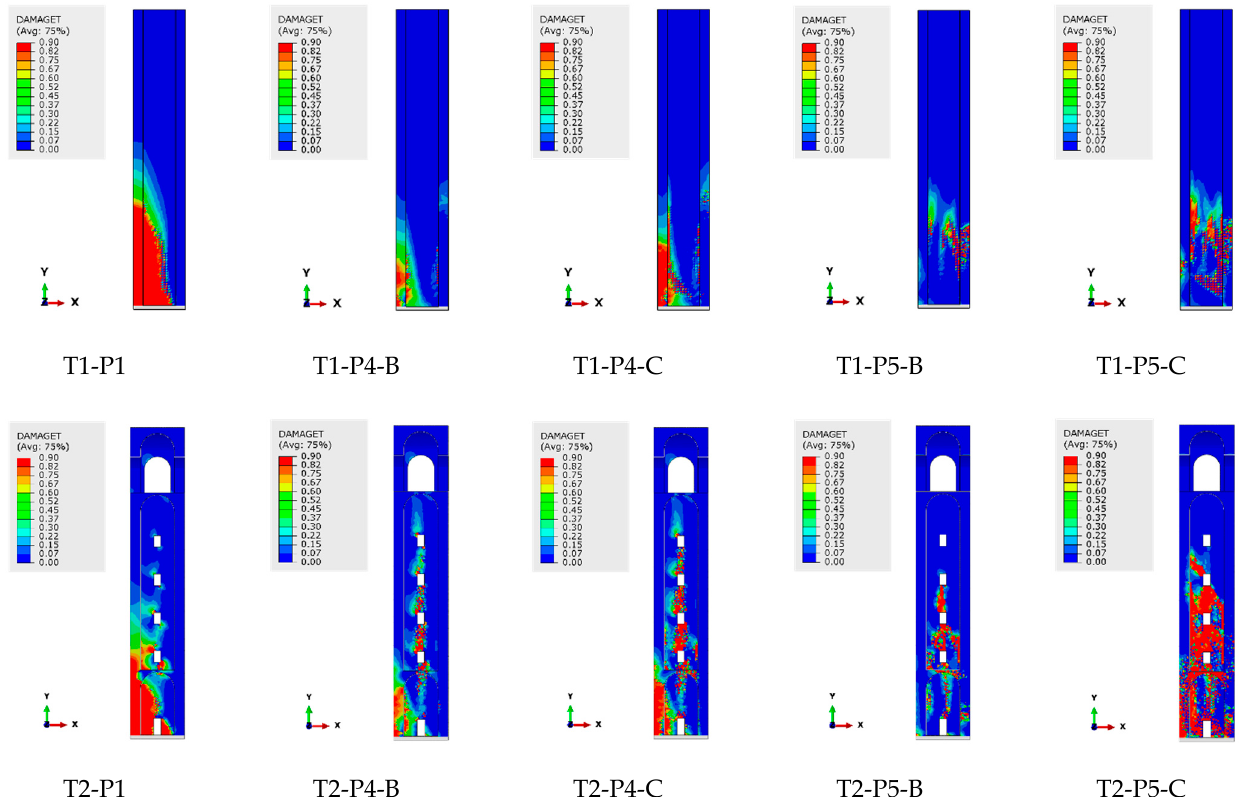
Figure 6. Damage pattern comparison between the hollow tower (Tower T1) in the upper images and the “realistic tower” (Tower T2) in the lower images respectively for the points defined in Section 2.2.